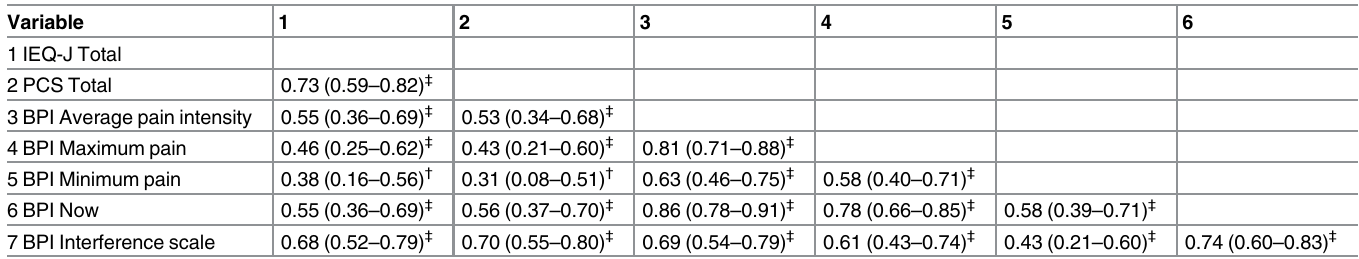
Table 5. Correlation coefficients (95%CI) among IEQ-J, PCS, and BPI.